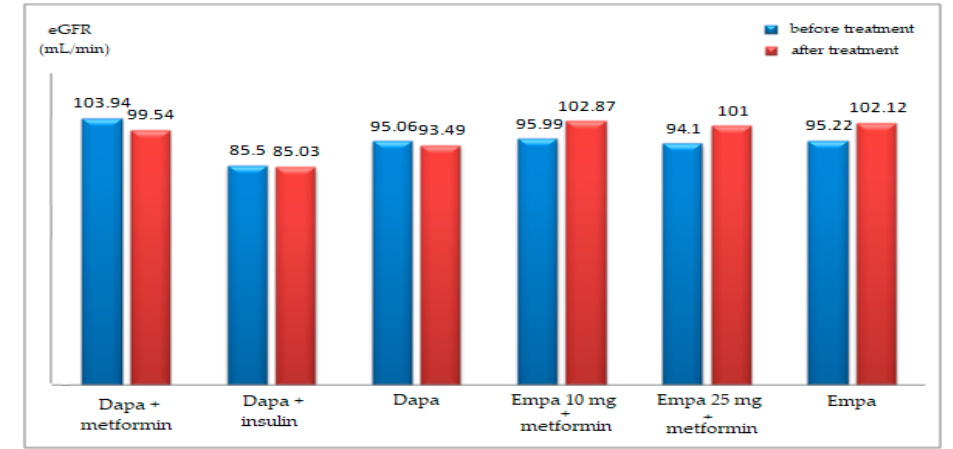
Figure 6. Average values evolution of the eGFR depending on the treatment